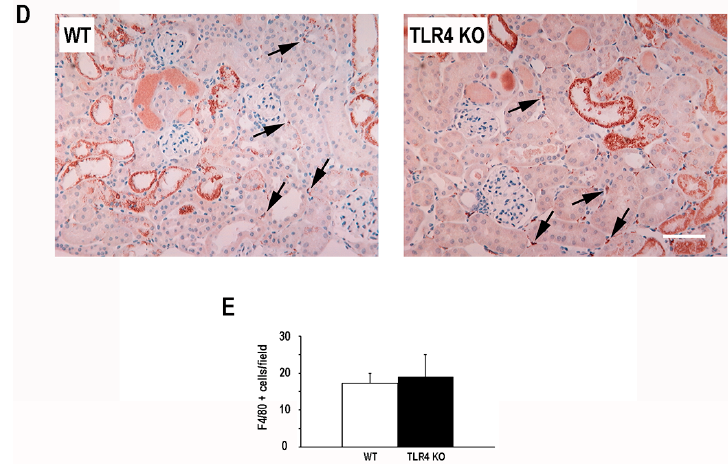
Figure 2. Deletion of TLR4 did not significantly alter the early inflammatory response in a mouse model of ischemic AKI. Panel A demonstrates representative Gr-1 staining (brown, indicated by arrows) for WT and TLR4-deletion (TLR4 KO) mice at 24 h following a 19-min bilateral renal artery clamp. Hematoxylin (blue) was used as a counterstain. Non-specific staining of some tubules was noted; Panels B and C show quantitation of nucleated, non-tubular Gr-1-positive cells/field and leukocyte esterase-positive cells/field (images not shown) in kidneys from the two groups at 24 h following a 19-min bilateral renal artery clamp (mean Gr-1+ or leukocyte esterase+ nucleated, non-tubular cells/field ±SD; 5–7 fields/animal; n = 4); Panel D demonstrates representative F4/80 staining (brown, indicated by arrows) for WT and TLR4-deletion (TLR4 KO) mice at 24 h following a 19-min bilateral renal artery clamp. Hematoxylin (blue) was used as a counterstain. Non-specific staining of some tubules was noted; Panel E shows quantitation of nucleated, non-tubular F4/80-positive cells/field in kidneys from the two groups at 24 h following a 19-min bilateral renal artery clamp (mean F4/80+ nucleated, non-tubular cells/field ±SD; 5–7 fields/animal; n = 4). Scale bar = 40 µm.